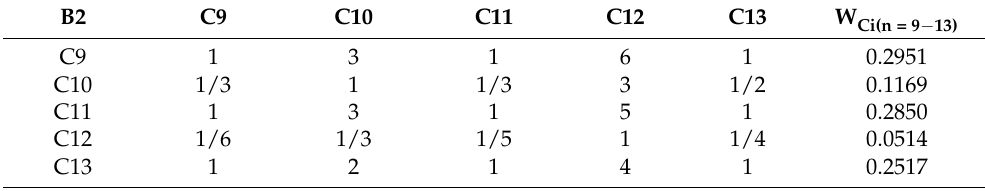
Table A3. B2-C i(i = 9 − 13) Judgment Matrix and Consistency Test.